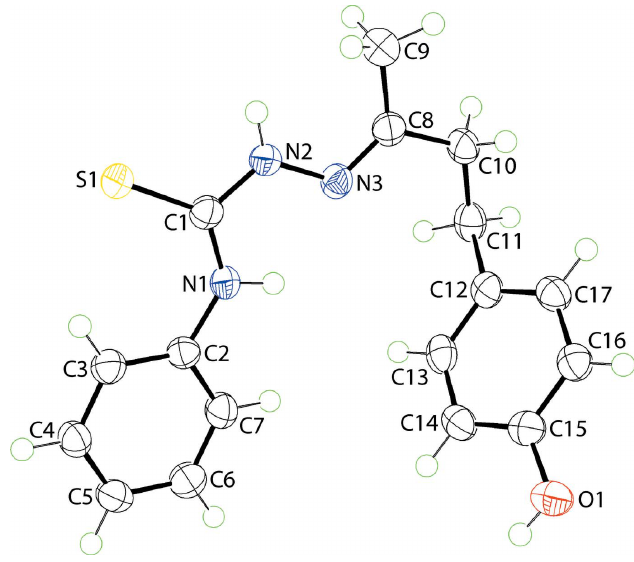
Figure 1 The molecular structure of (I) showing the atom-labelling scheme and displacement ellipsoids at the 70% probability